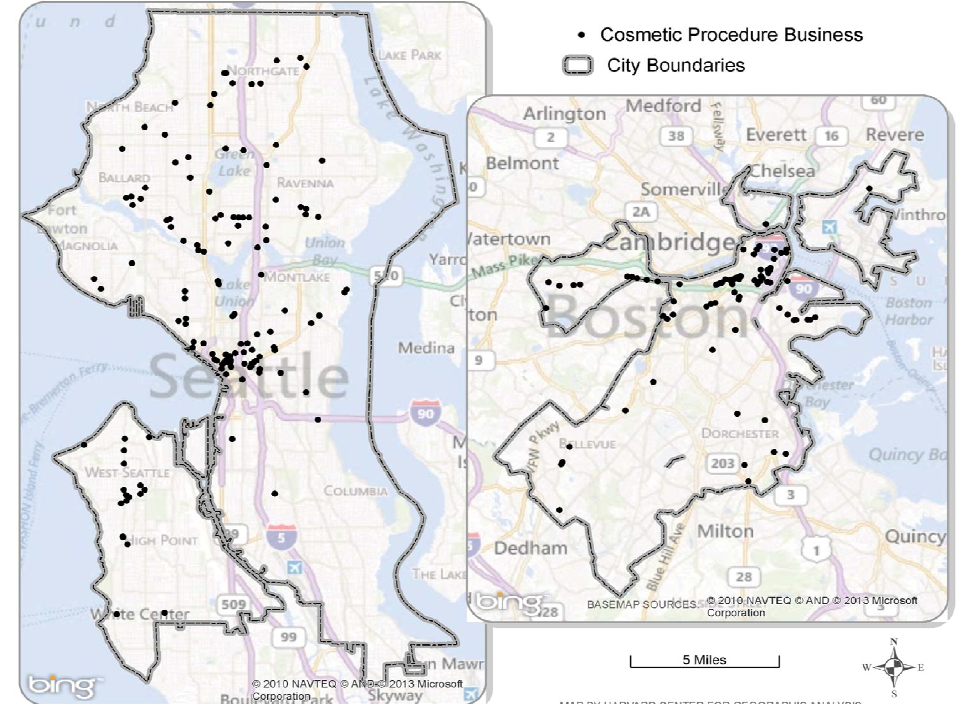
Figure 1. Boston and Seattle cosmetic-procedure businesses identified and confirmed via websearch (Method 1) and keyword search of ESRI Business Analyst database (Method 2),